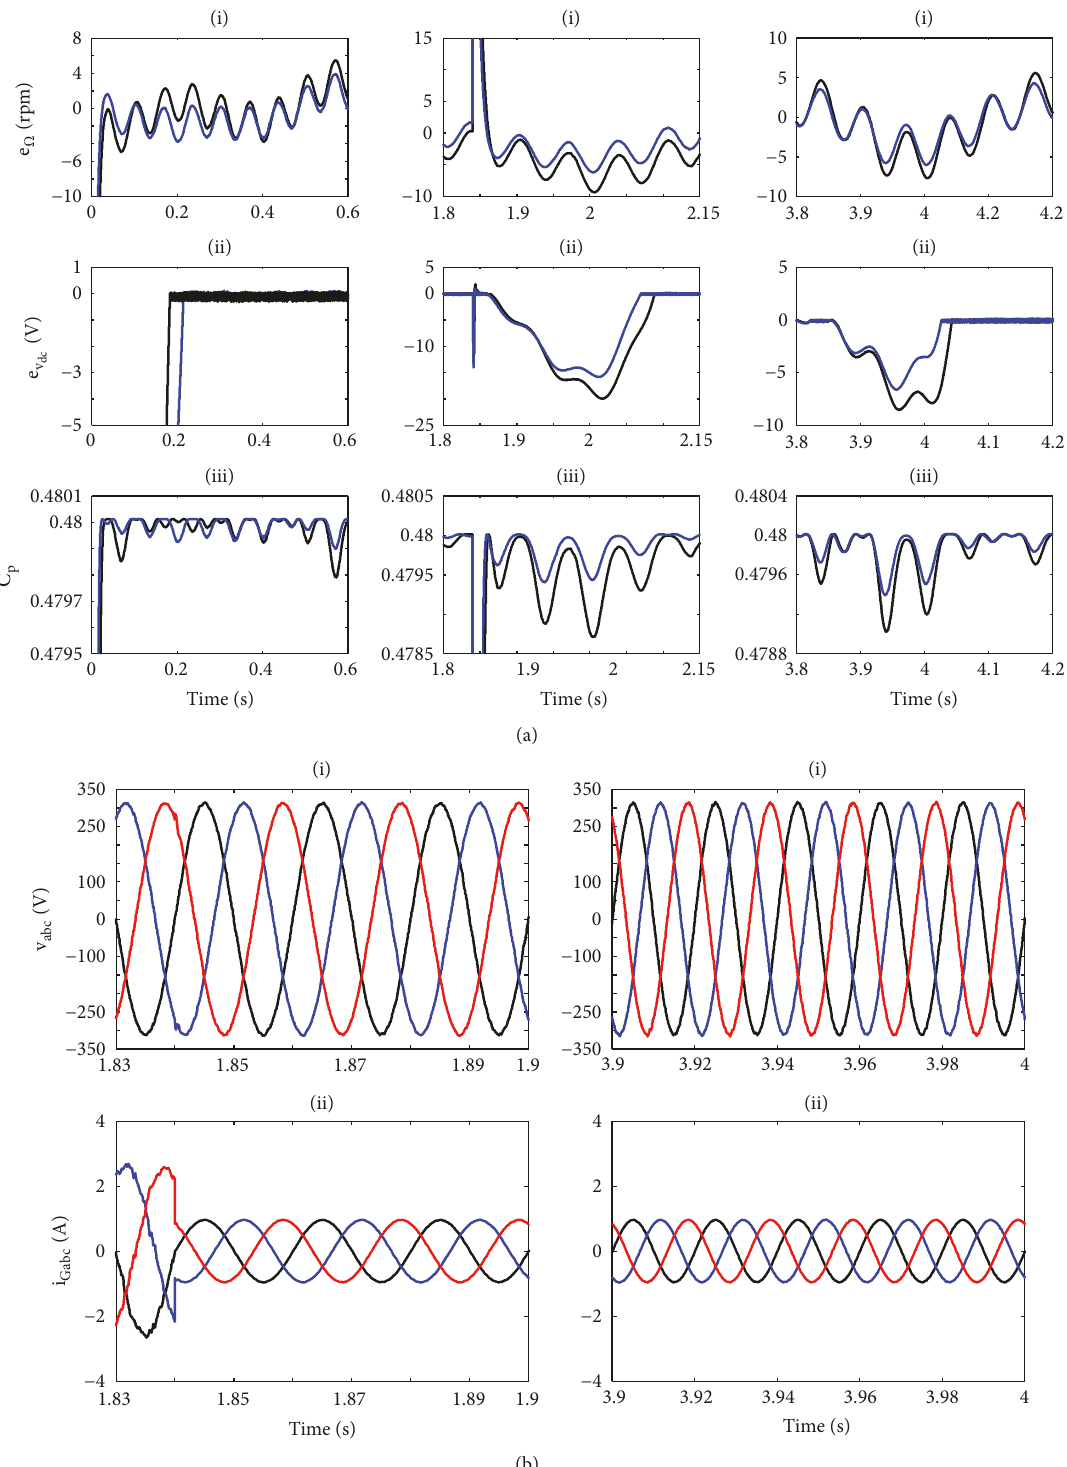
Figure 14: Control system response to wind speed fluctuations with parameters uncertainties and grid connected to standalone mode transition. The transition occurs at time 𝑡 = 1.84𝑠 . (a) Zoom on (blue line: RBF-NSMC, black line: SMC): (i) generator speed error, (ii) dc-link voltage error, and (iii) power coefficient. (b) Zoom on (proposed RBF-NSMC): (i) 3-phase voltage across the LCL filter capacitor; (ii) 3-phase total grid plus local load